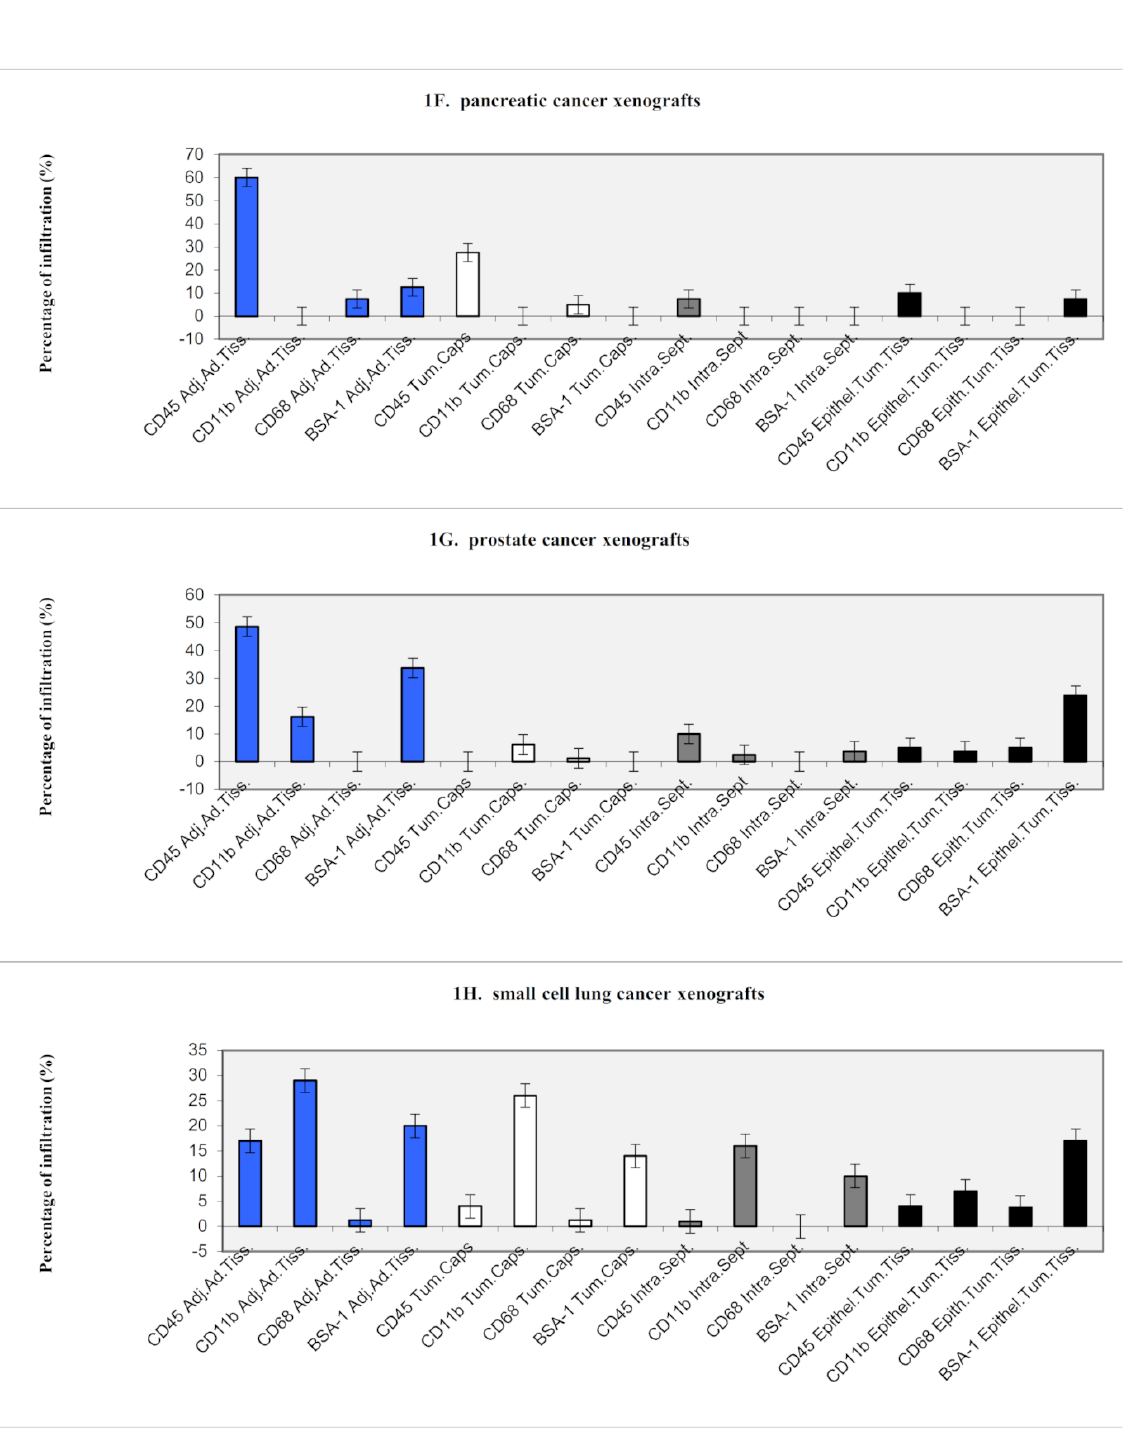
Figure 1. ( A ) breast cancer xenografts, ( B ) colon cancer xenografts, ( C ) melanoma xenografts, ( D ) ovarian cancer xenografts, ( E ) neuroblastoma xenografts, ( F ) pancreatic cancer xenografts, ( G ) prostate cancer xenografts, and ( H ) small cell lung cancer xenografts. Summary of the histological localization of the immune infiltrating cells in the xenograft models. Percentage of cells labeled by selected antigens in scid mice breast cancer, colon cancer, melanoma, ovarian cancer, neuroblastoma, pancreatic cancer, and pfp/rag2 mice prostate cancer and small cell lung cancer, relating to their localization in the adjacent adipose tissue (Adj.Ad.Tiss.), the tumor capsule (Tum.Caps.), the intra-tumoral septae (Intra.Sept.), and epithelial tumor tissue (Epithel.